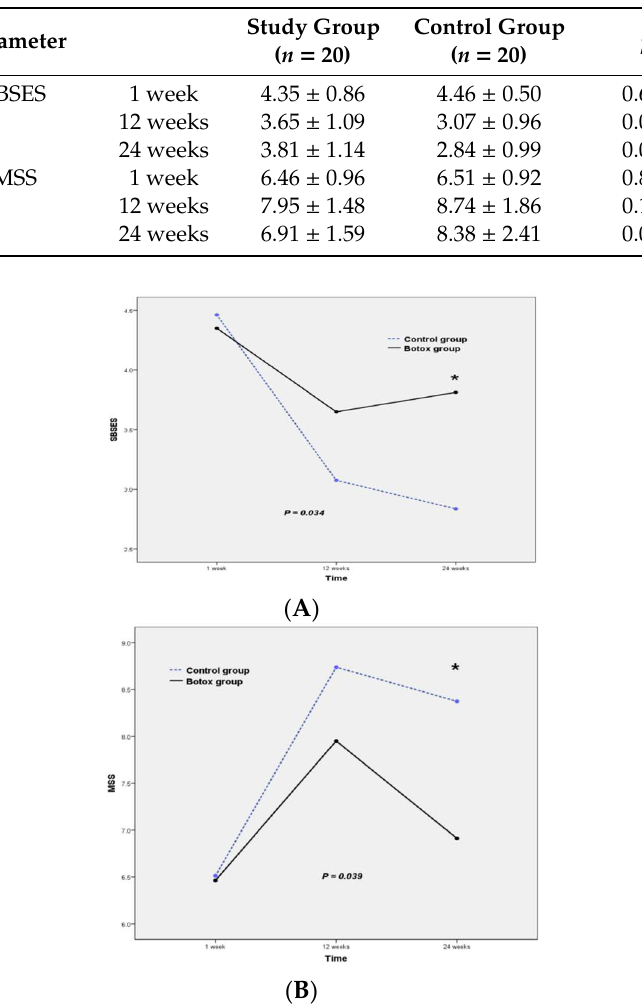
Figure 2. Mean score of the Botox ( n = 20) and control groups ( n = 20) on ( A ) the Stony Brook Scar Evaluation Scale (SBSES) and ( B ) the Manchester Scar Scale (MSS). * indicate that p -value is < 0.05.